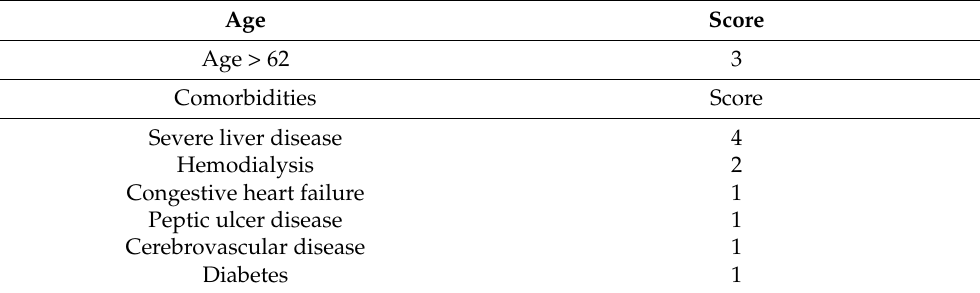
Table 2. ‘Surgery for acute mesenteric infarction mortality score’ system.